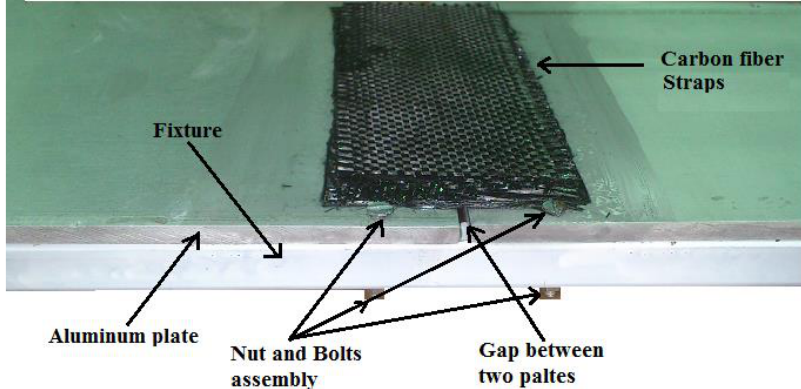
Figure 1. Bonding between carbon fiber straps and aluminum plates.